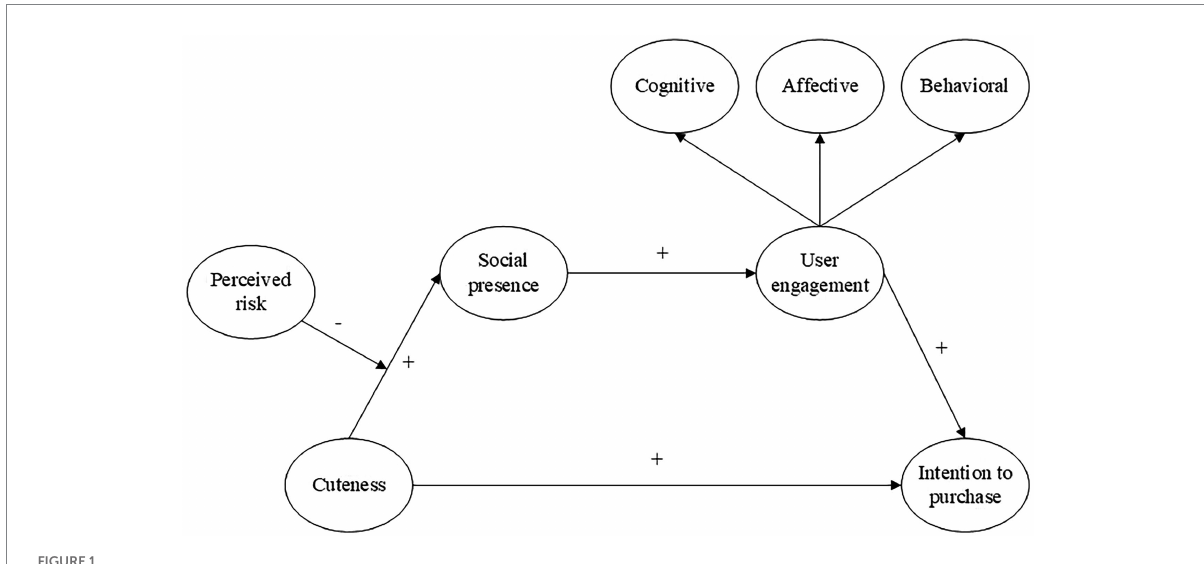
FIGURE 1 Research